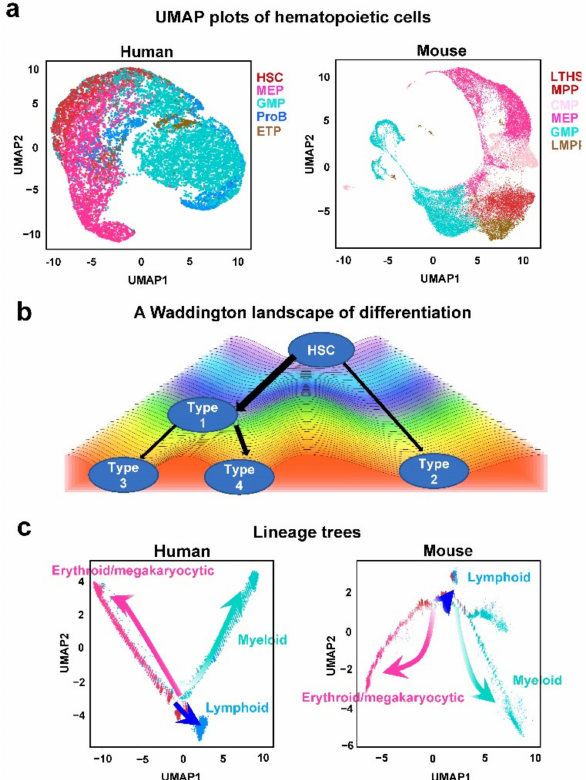
Figure 2. ( a ) UMAP plots of human and mouse hematopoietic cells, colored by cell types. ( b ) A Waddington landscape of differentiation (generated with the program from https://github.com/ zzwch/waddingtonplot, accessed on 21 January 2022). A cell fate was restricted at a ridge, and determined once a cell fell into a valley. ( c ) Human and mouse lineage trees inferred by Monocle 2 using reverse graph embedding at two